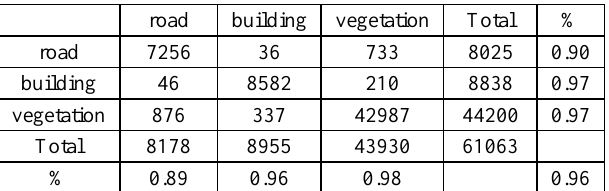
Table 2. Confusion matrix for